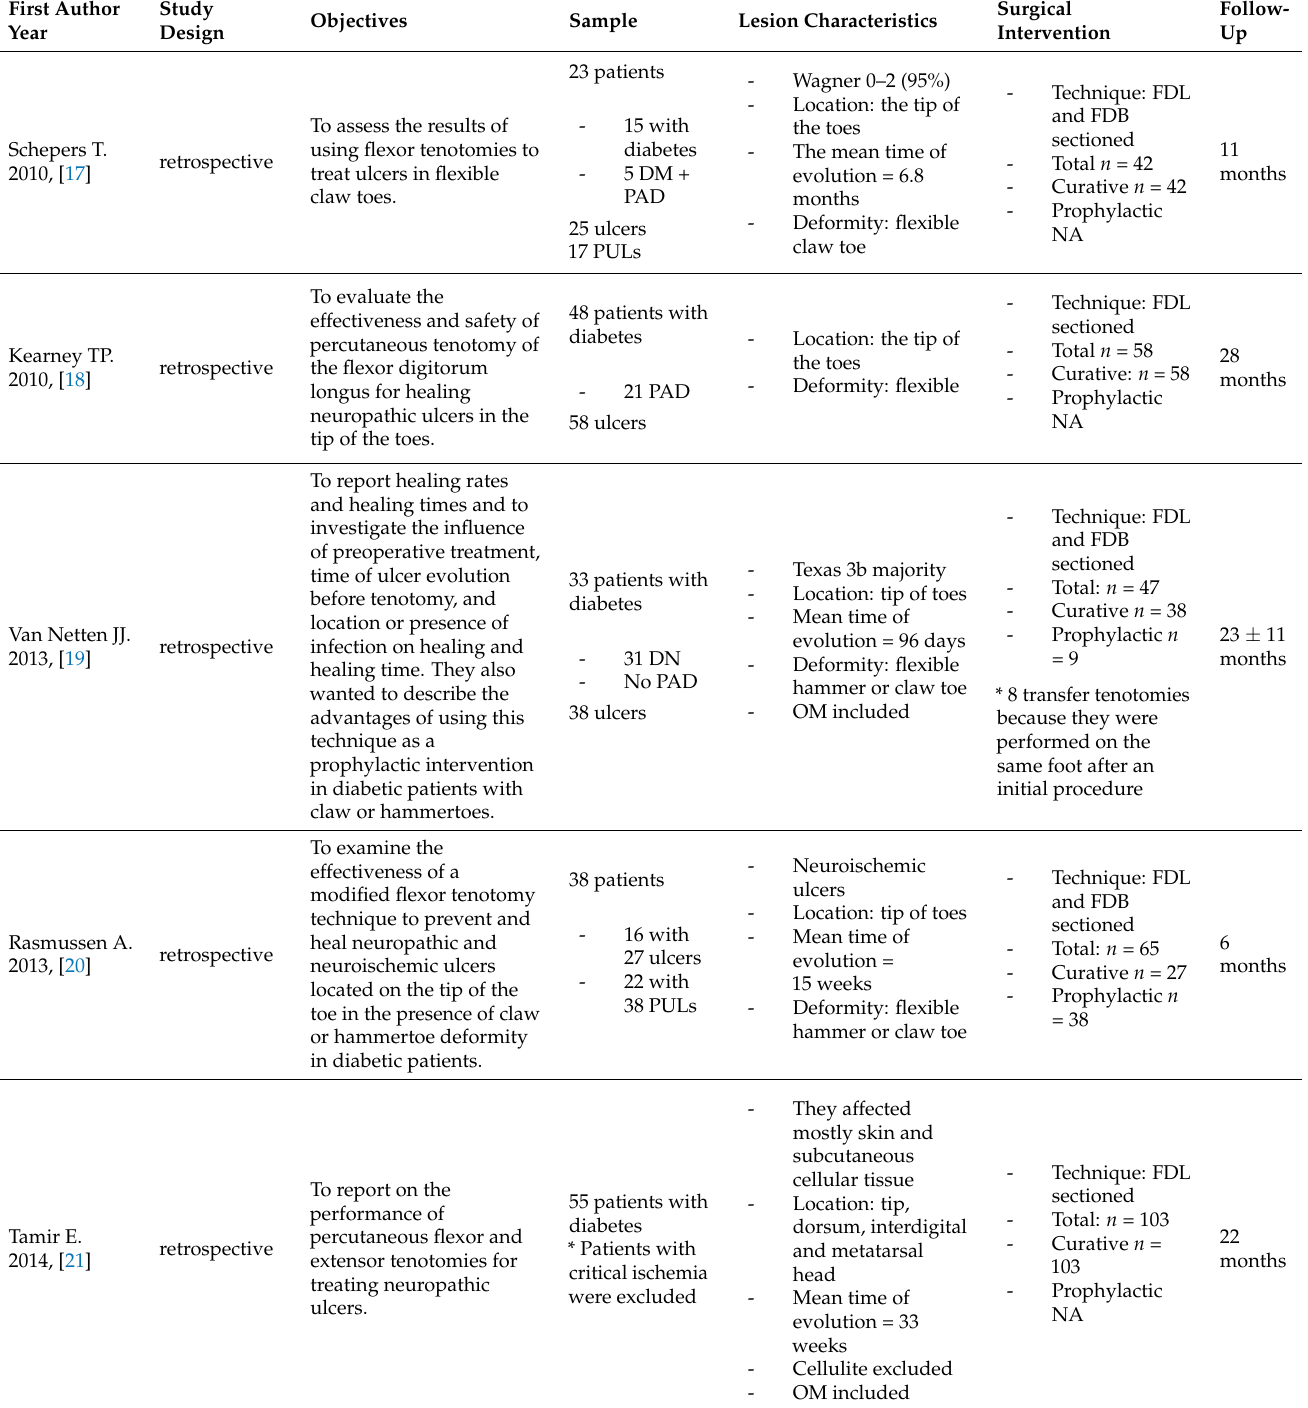
Table 1. General characteristics of the included